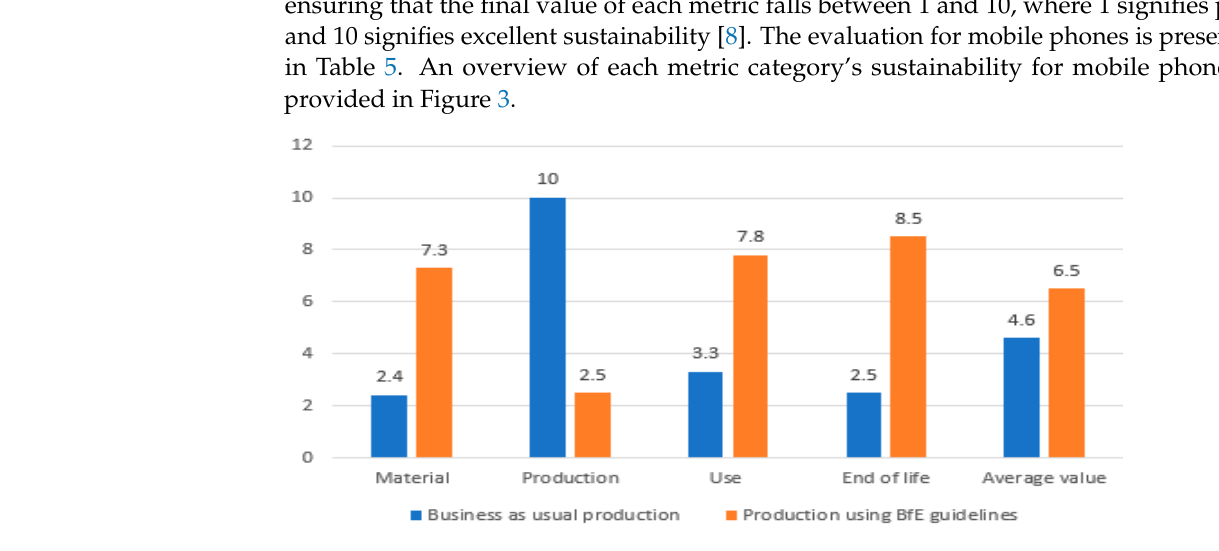
Figure 3. Overview of each metric category with respect to sustainability for a mobile phone.